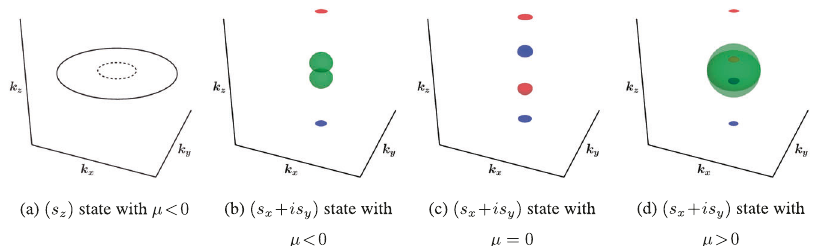
Fig. 2 Gap structure of the superconducting states. a ( s z ) state with the chemical potential μ < 0 − A solid(dashed) ring indicates the nodal ring which is protected by the non-trivial winding number 1( − 1). Each gapless region in ( s z ) state have two-fold degeneracy protected by the chiral symmetry ( b ) ( s x + is y ) state with μ < 0, ( c ) ( s x + is y ) state with μ = 0, and d ( s x + is y ) state with μ > 0 − Each surface indicates the non-degenerate Bogoliubov Fermi surface and the color represents its Chern number. Green, red, and blue indicates 0, − 1, and 1,